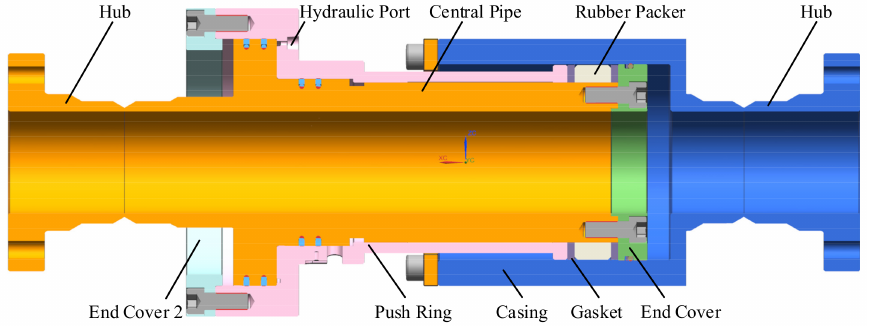
Figure 1. 3D model of the subsea retractable